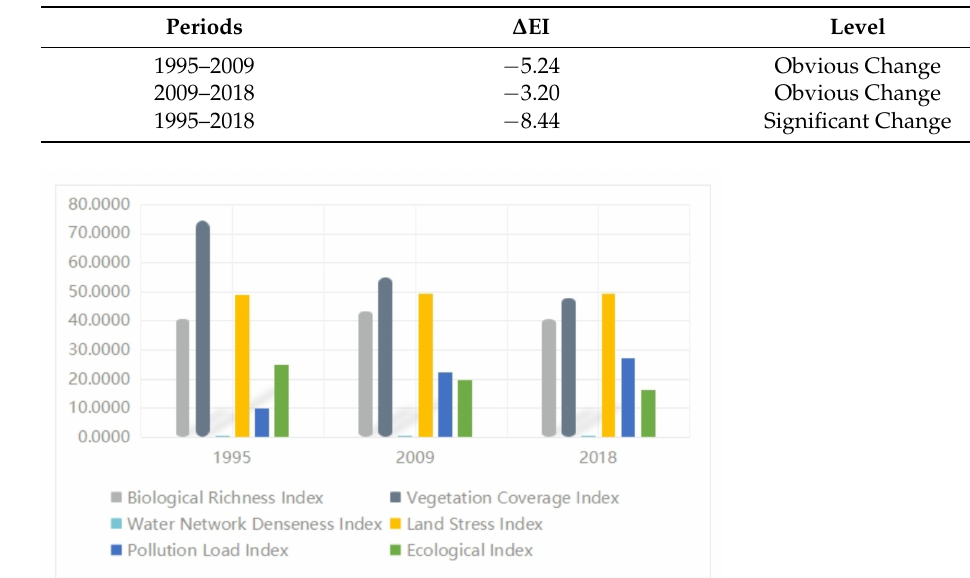
Table 11. Results of changes in the eco-environment in Hetian.